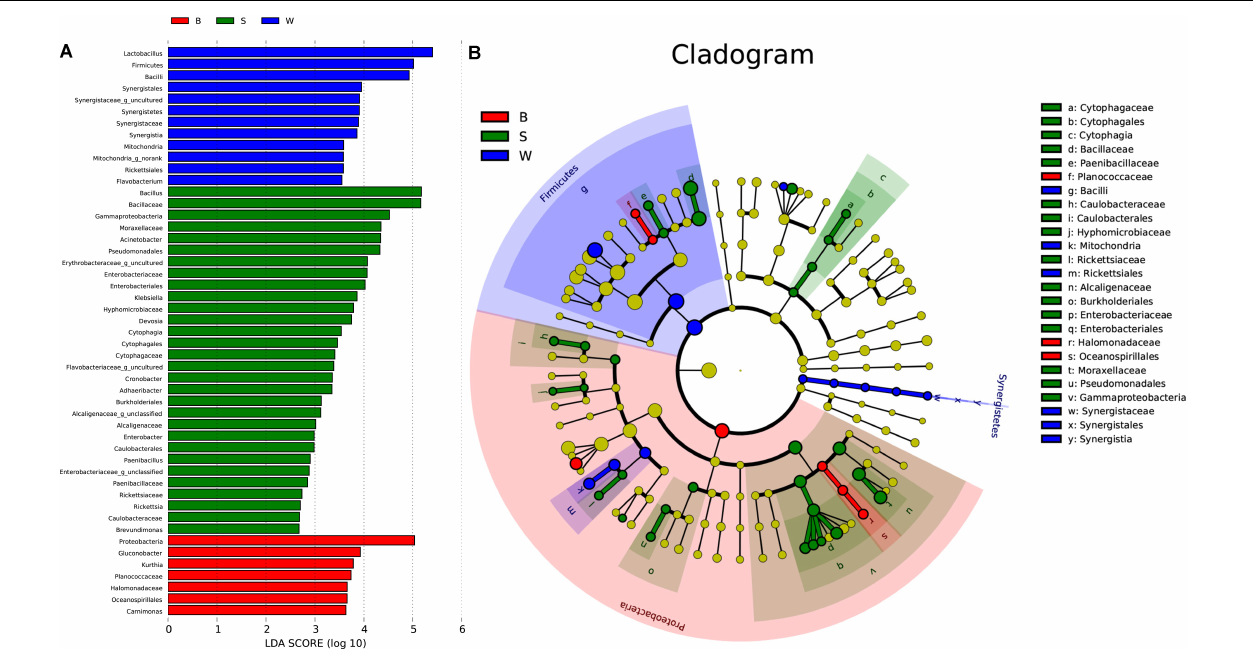
FIGURE 7 | Key phylo-types of bacteria analysis in three types of starters by using LEfSe. (A) Indicator bacterial groups with the three types of starters with LDA values higher than 2.0. (B) Cladogram indicating the phylogenetic distribution of microbial species associated with the three types of starter. Species with LDA values of 2.0 or higher determined by LEfSe are displayed. Differences are represented in the color of the most abundant class. The diameter of each circle is proportional to the abundance of the taxon. The strategy of multiclass analysis is nonstrict (at least one class differential). Circles represent phylogenetic levels from domain to genus inside out. Labels are shown of the phylum, class, and family